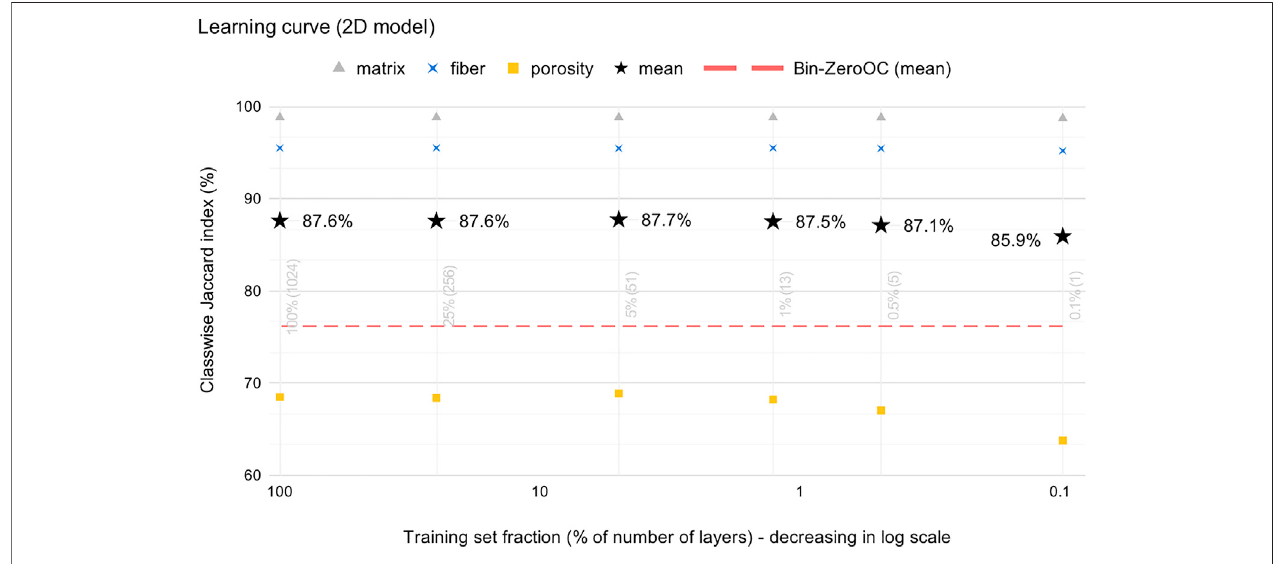
FIGURE 10 | Learning curve of the 2D model with default hyperparameters ( Table 1 ). 1024 consecutive slices from the training set were used with progressively fewer data by eliminating slices from the bottom (i.e., closer to the validation set, see Section 2.1.4 ) of the stack. All the models are evaluated with the validation set.